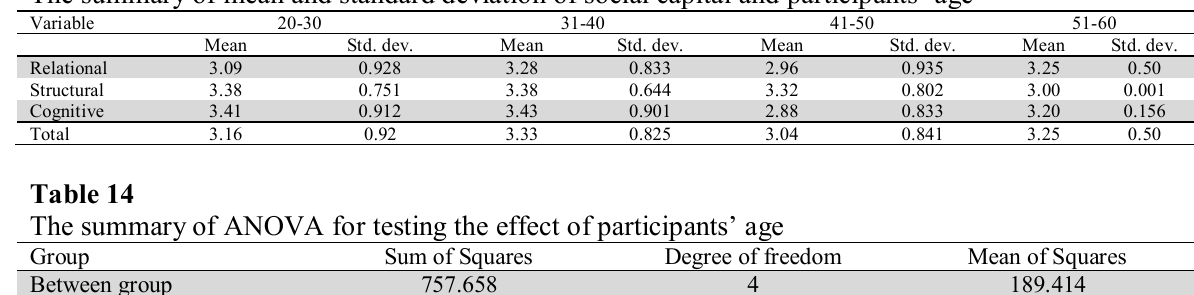
The summary of Chi-Square for testing the effect of job experience Group Sum of Squares Degree of freedom Mean of Squares Between group 173.177 4 444.793 Inside group 23407.367 115 203.541 F-value = 2.185 Sig. = 0.075